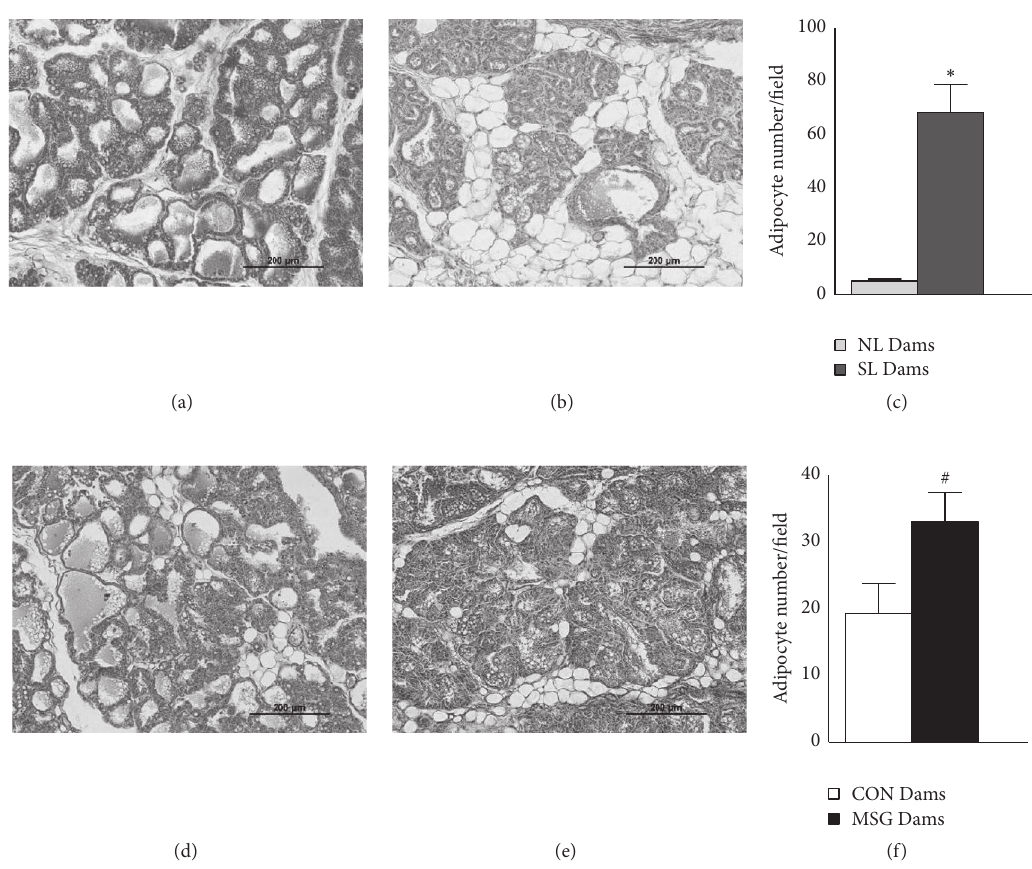
Figure 2: The effect of offspring manipulations on mammary gland histology in lactating dams at 21 days of lactation. Representative photomicrographs (magnification 200x; scale bar, 200 𝜇 m) of H&E-stained mammary gland tissue from lactating dams at 21 days of lactation: ((a)-(b)) NL and SL, respectively, and ((d)-(e)) CON and MSG, respectively. Quantitative analyses of adipocyte numbers in mammary glands are represented in (c) and (f). The data are mean ± SEM of 20 sections collected from at least 3 dams/group. Symbols above the bars represent statistical differences in Student’s t -test ( 𝑝 < 0.05 ). ∗ NL Dams versus SL Dams; # CON Dams versus MSG